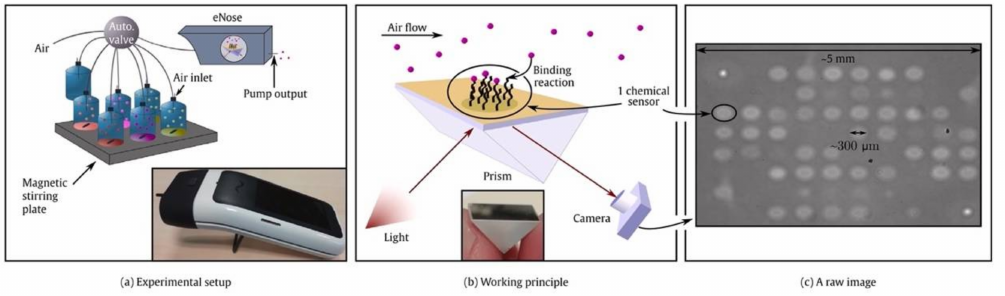
Figure 4. The transduction mechanism of the optoelectronic nose reported by Barthelm é [4]. Reprinted with permission from Ref. [4]. Copyright 2020 Elsevier.